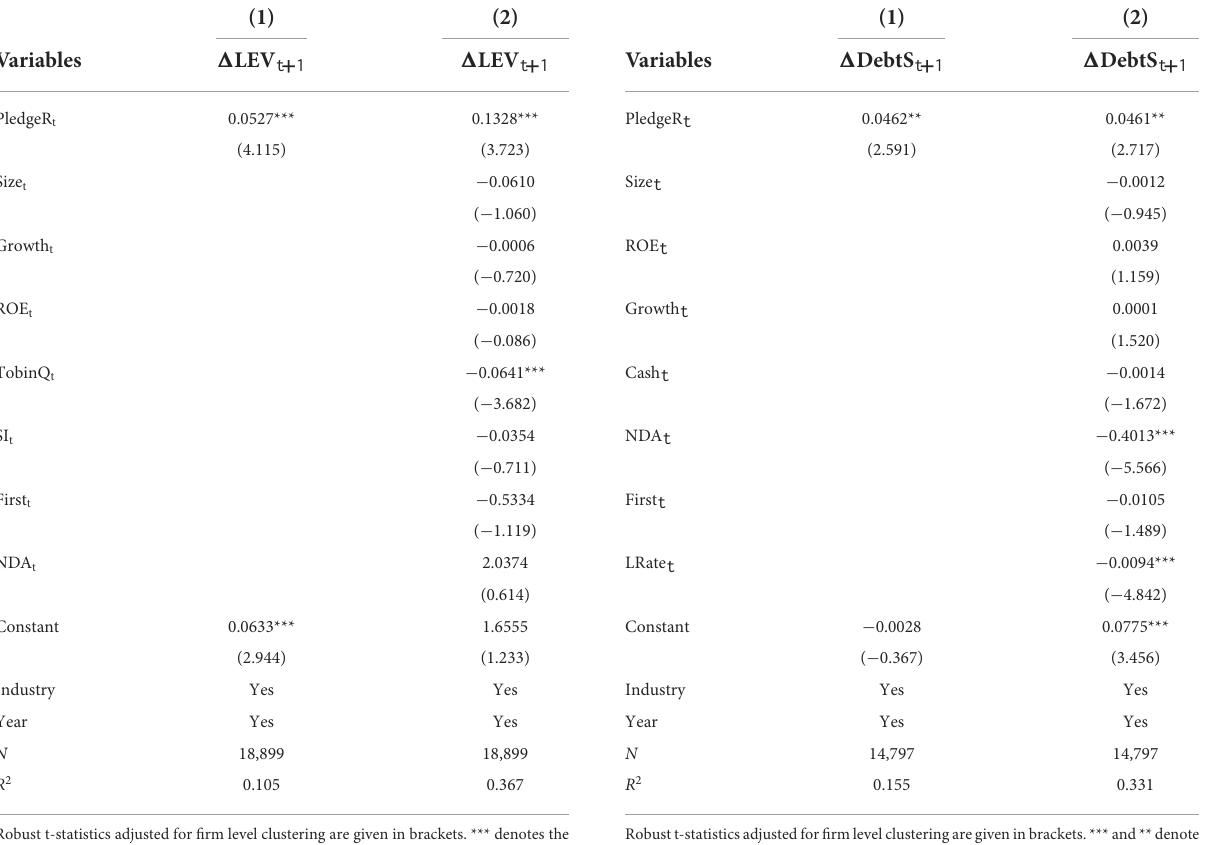
TABLE 3 The association between share pledge of ultimate owner and firm’s financial leverage.